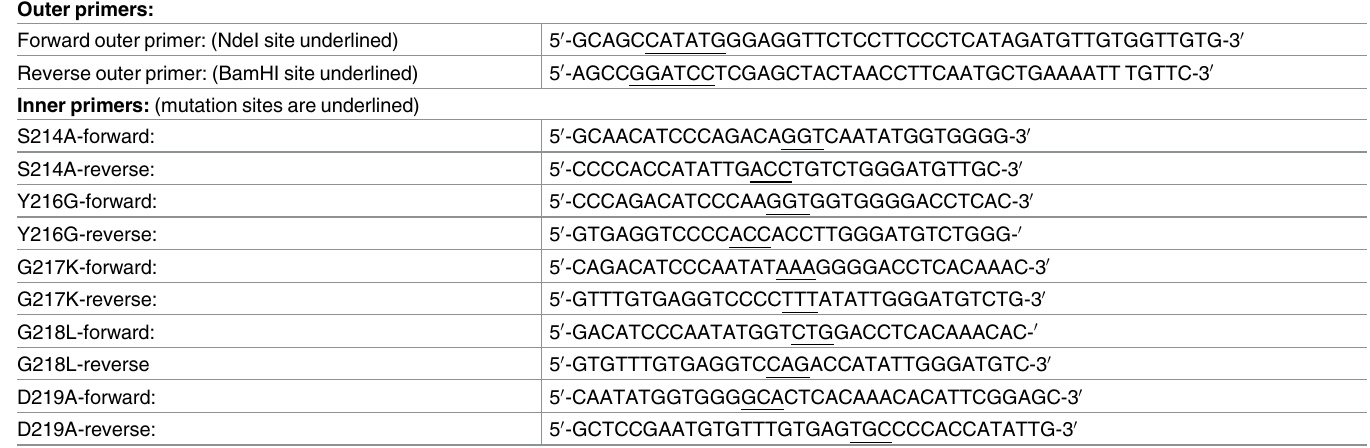
Table 2. PCR primers for cloning the α 2A loop2 mutants. Outer primers: Forward outer primer: (NdeI site